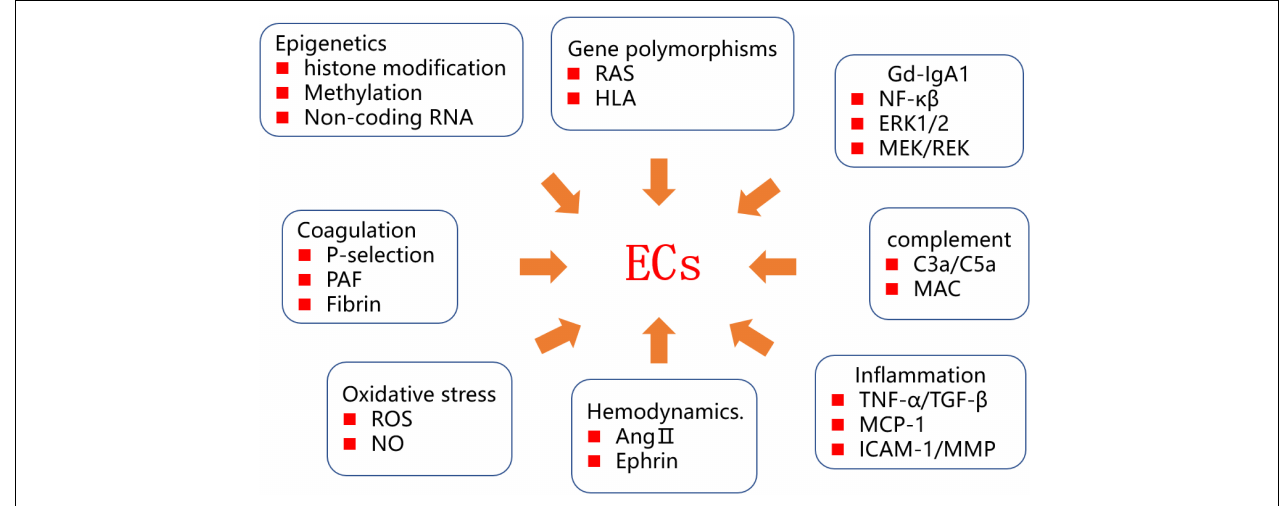
FIGURE 2 | Diagram of IgAV endothelial injury